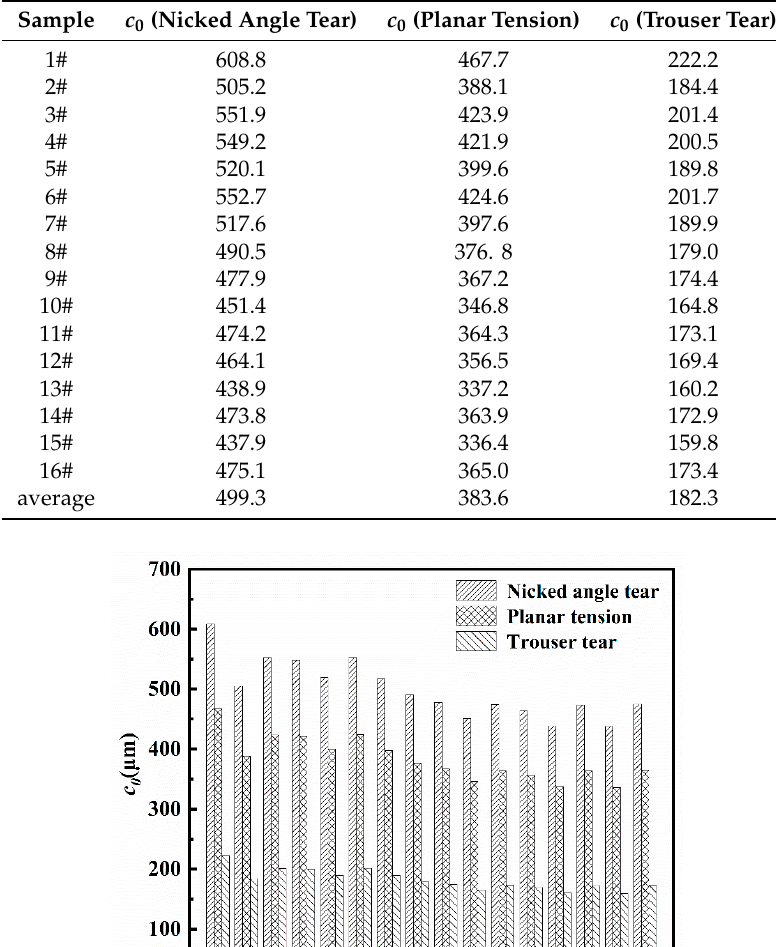
Table 2. Crack precursor size c 0 ( µ m) for di ff erent samples.